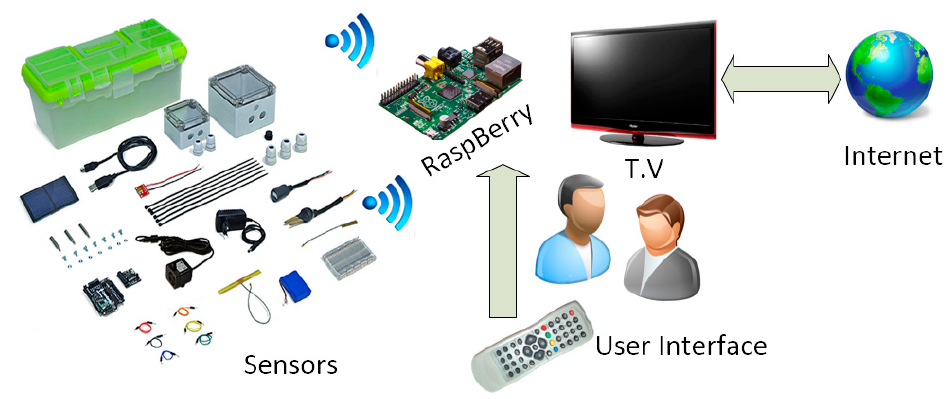
Figure 18. Remote control platform of the irrigation system.